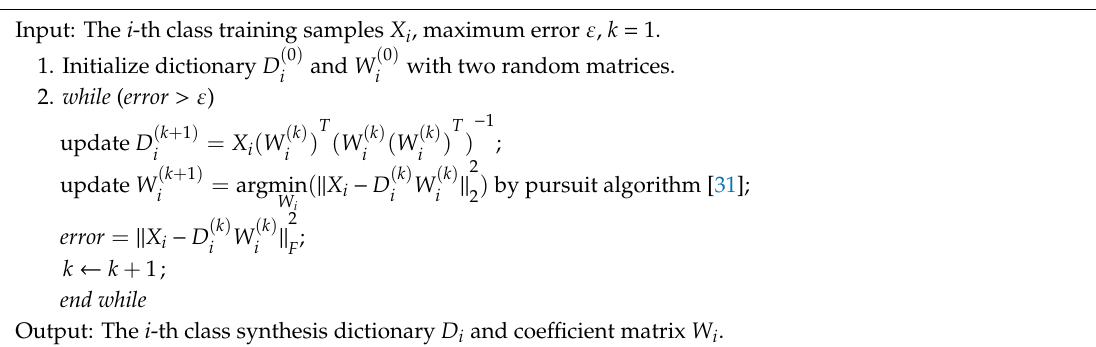
Algorithm 1. Obtain the optimal solution of D i and W